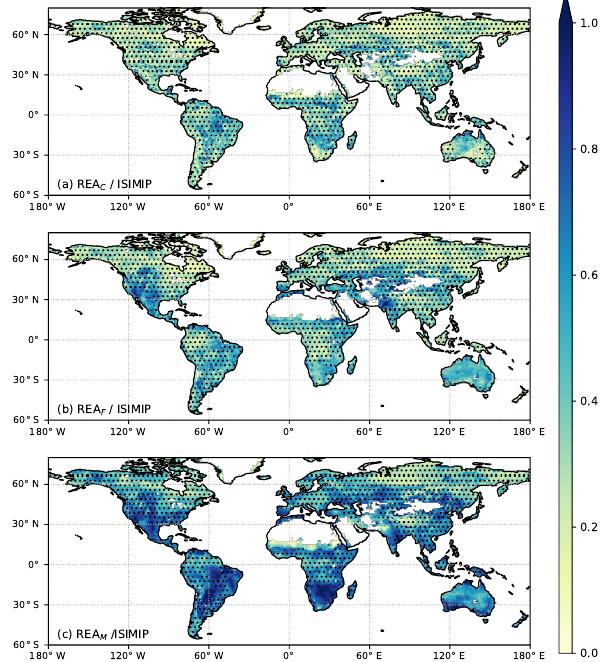
Figure 2. Differences between (cid:49) NPP in 2095–2099 compared to 2001–2005 from the REA average and ISIMIP ensemble mean (gCm − 2 y − 1 ). Red indicates where the REA averages predict (cid:49) NPP greater than the ISIMIP ensemble mean. Blue indicates where the REA averages predict (cid:49) NPP less than the ISIMIP en- semble mean.